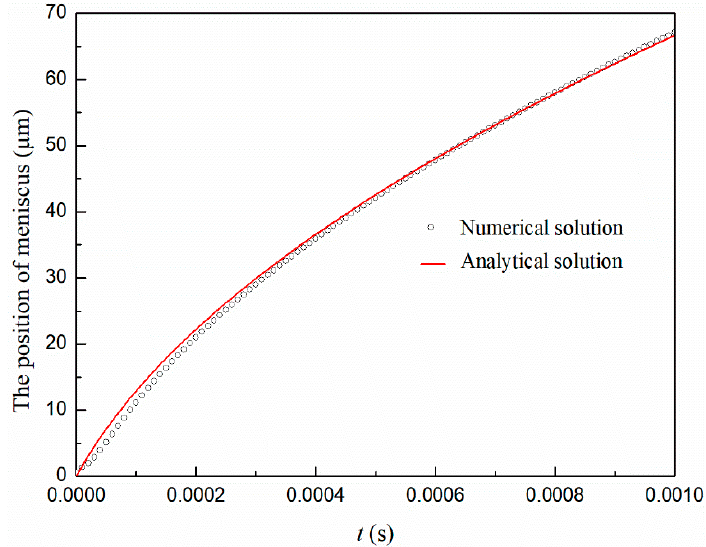
Figure 2. The numerical and theoretical position of moving meniscus, and the analytical solution is Equation (11).